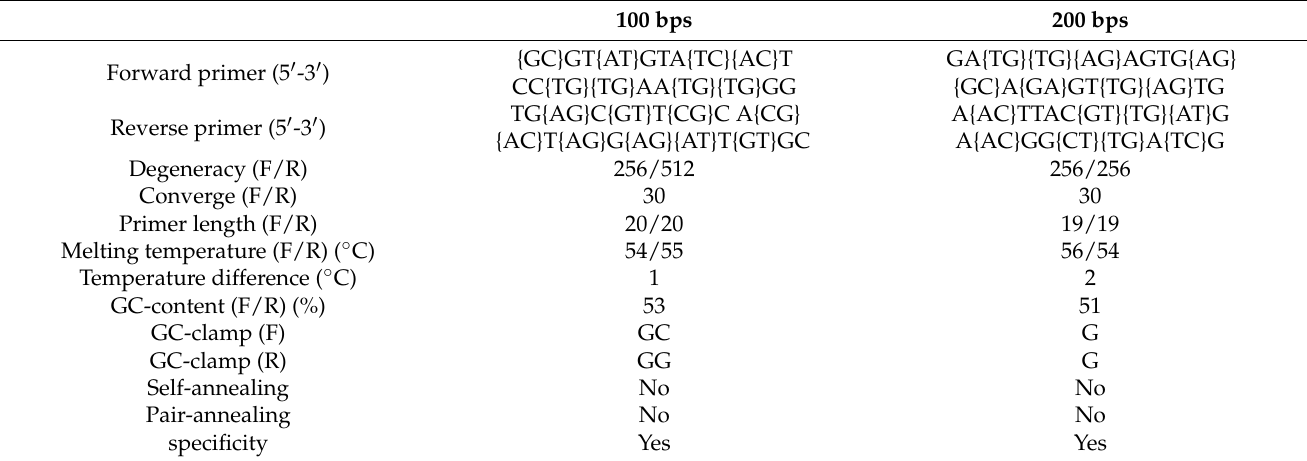
Table 4. Experimental results on 100 bps and 200 bps DNA templates. 100 bps 200 bps